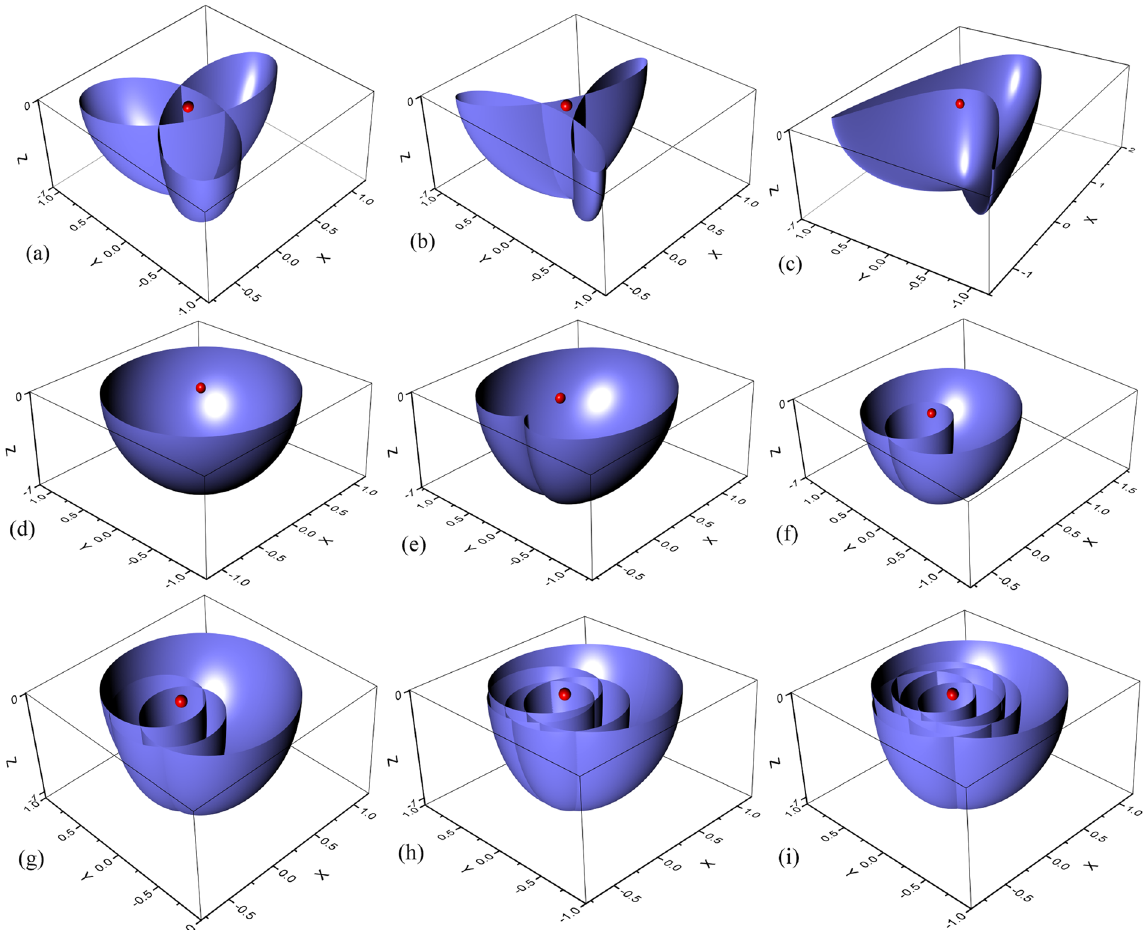
Figure 1. Plots of the surfaces in the auxiliary space ( x , y , z ) to illustrate the relation between winding and Chern number. The corresponding parameters in equations of the 3D surfaces are listed in Table 1. The red dot denotes the origin of the auxiliary space (0, 0, 0). The winding numbers can be figured out from the curves in the xy